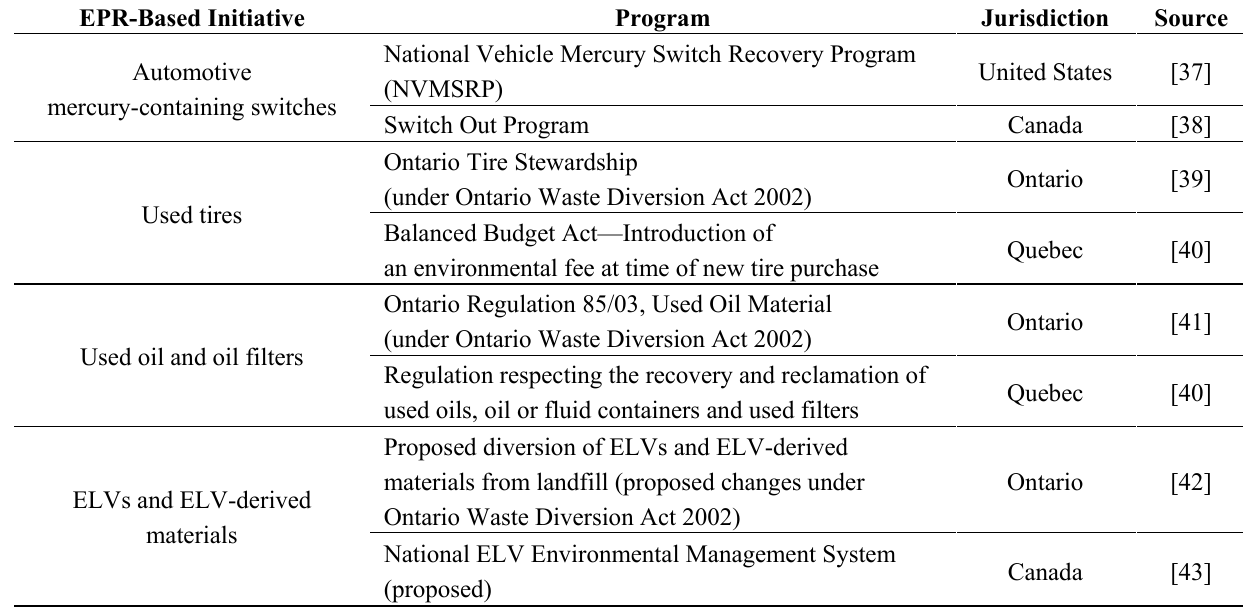
Table 2. Examples of extended producer responsibility (EPR)-based initiatives for ELV-derived materials in Canada and the United